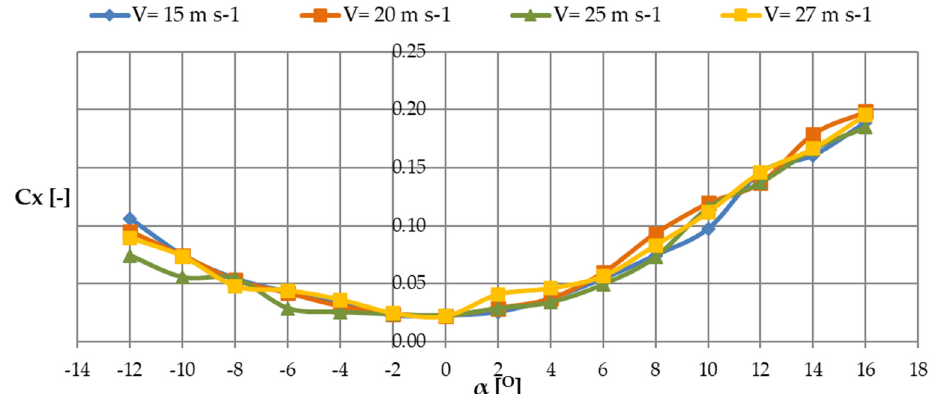
Figure 12. Summary plot of lift force coefficient, Cz, for positive and negative angles of attack, α , for all airflow speeds tested.